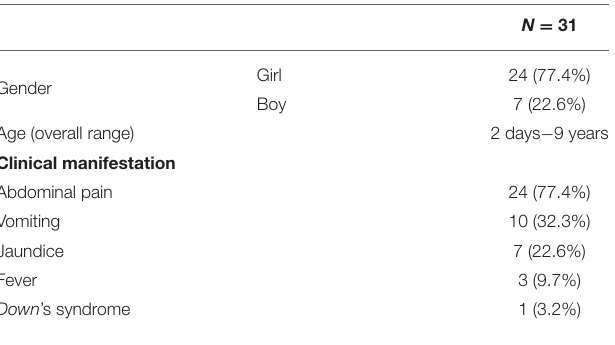
TABLE 1 | Clinical characteristics of pediatrics with PBM.